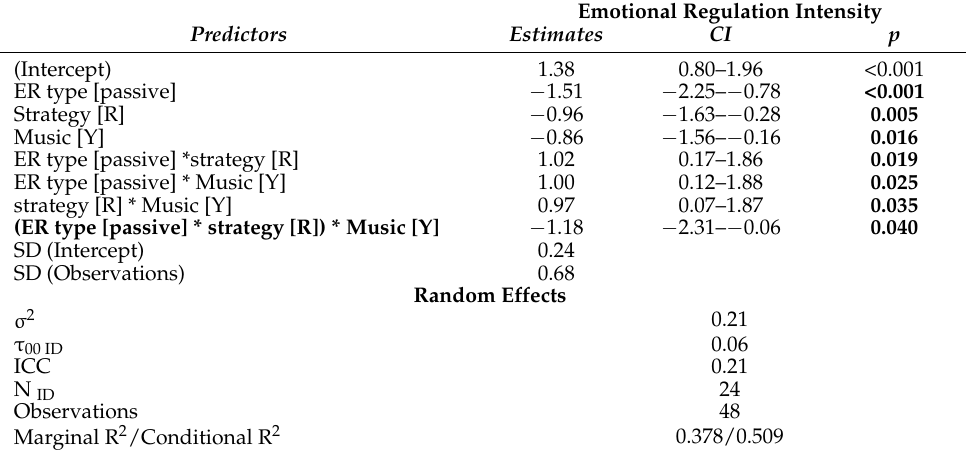
Table A3. Participants with higher musical sophistication